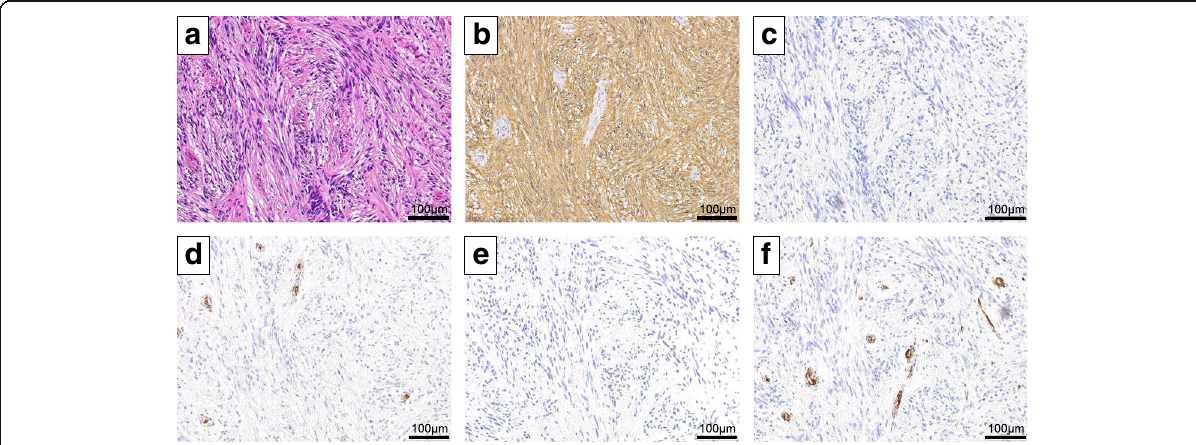
Fig. 4 Histopathological findings. a Histopathological findings revealed spindle-shaped cells (hematoxylin and eosin stain, ×200). b – f Immunohistochemical staining of tissue sections with nuclei counterstained with hematoxylin. b The tumor showed cytoplasmic expression of S-100 (×200). c The tumor was negative for KIT (×200). d The tumor was negative for CD34 (×200). Vascular endothelial cell of the tumor was immunostained. e The tumor was negative for Desmin (×200). f The tumor was negative for α -SMA (×200). Vascular smooth muscle cells of the tumor were